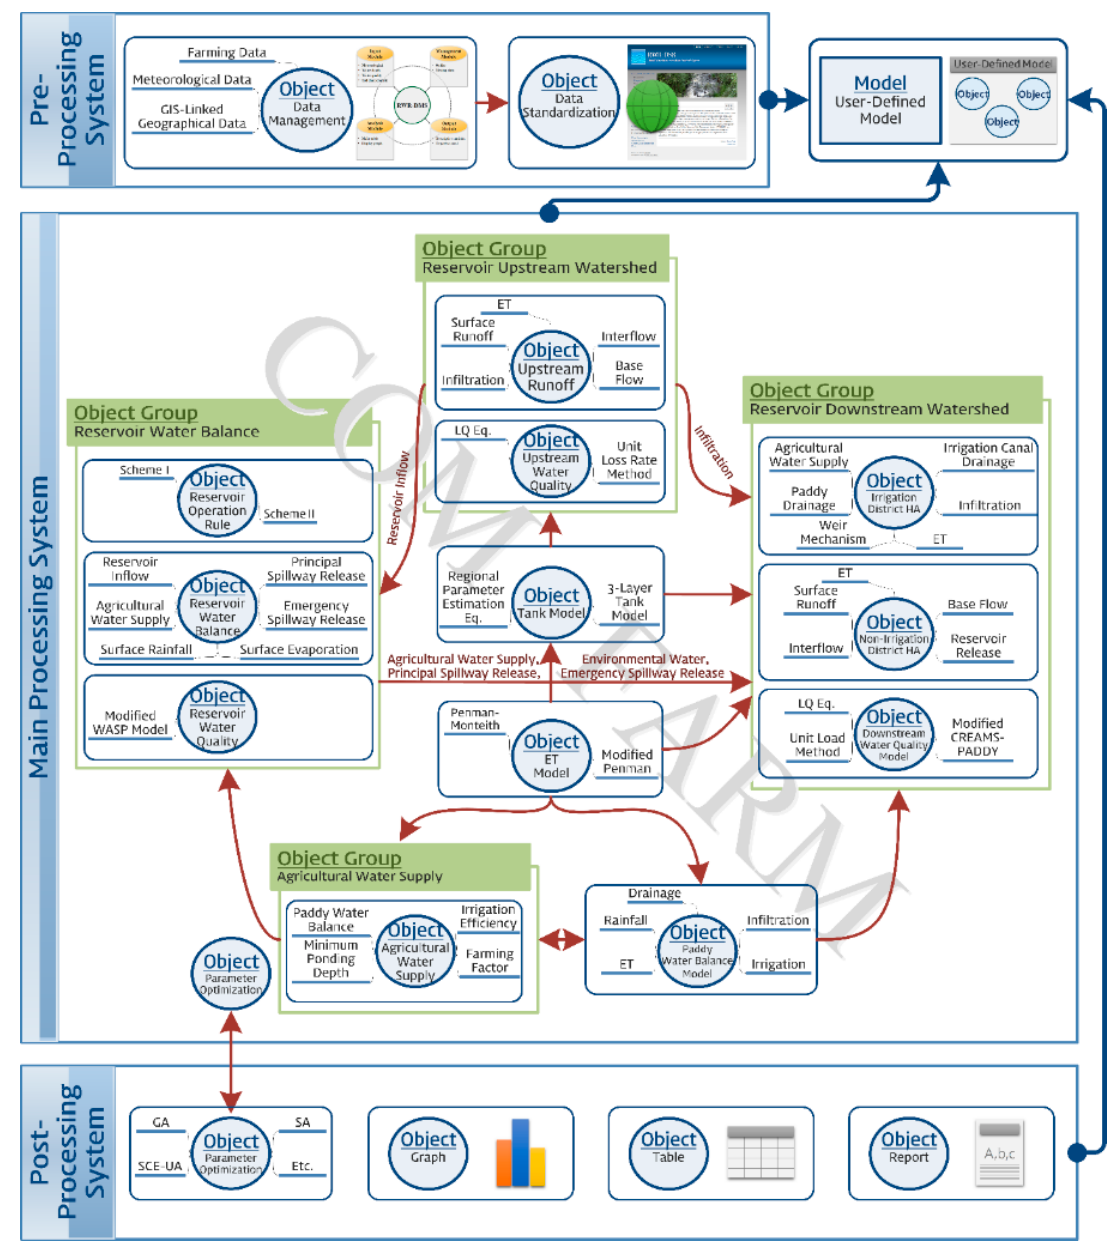
Figure 4. Agricultural watershed ‐ modeling system with various linkable objects, including dataflow, execution phases, and output data. Connectivity arrows indicate the dataflow between the source and target; object represents a functional sub ‐ unit that has been realized into an individual module in COMFARM.